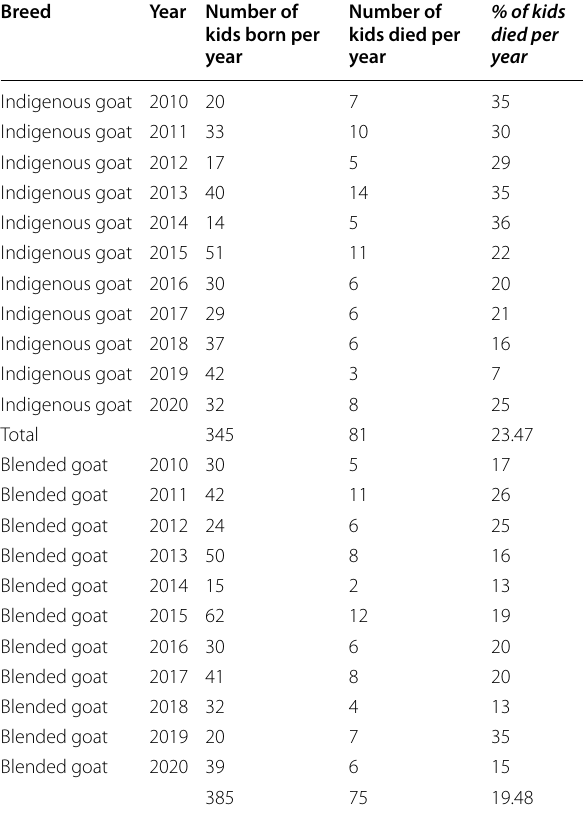
Table 3 Number of kids born and mortality in the 10-year interval